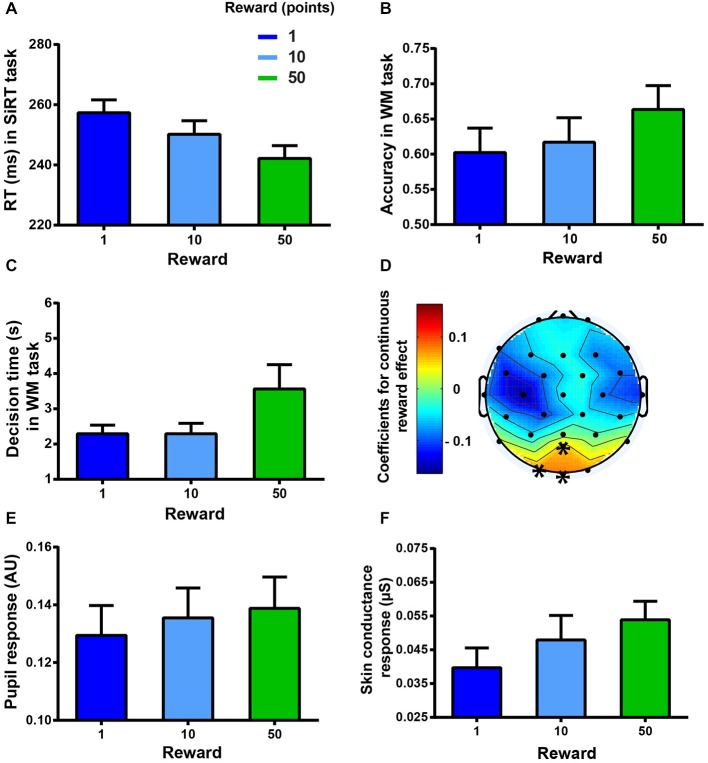
Markers of motivation. Error bars represent standard errors of the mean. (A) Mean RT (ms) as a function of the reward condition in the SiRT task. (B) Mean accuracy as a function of the reward condition in the WM task. (C) Mean decision time (s) as a function of reward condition in the WM task. (D) Coefficients of the reward effect on the high gamma band (60–140 Hz) activity in the WM task. Higher incentives led to higher activation on POz, Oz, and O1 electrodes (marked by asterisks, p < 0.05). (E) Mean pupil response as a function of reward condition in the WM task. (F) Mean SCR as a function of reward condition in the WM task.